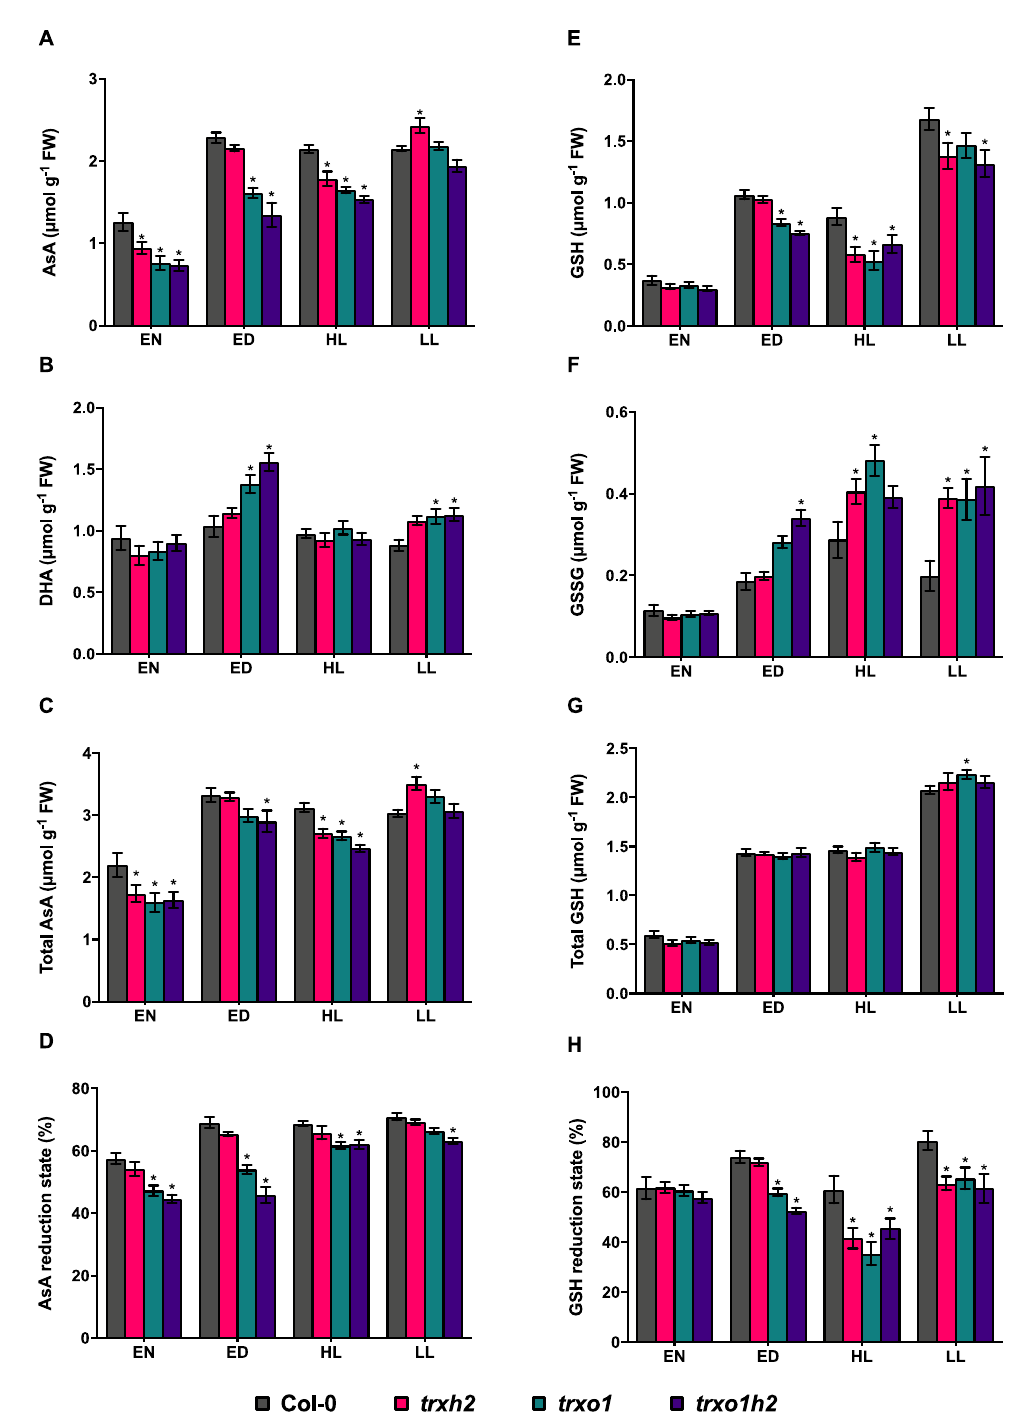
Figure 6. The redox couples of ascorbate (AsA) and glutathione (GSH) in the wild type (Col-0) and the mutant lines ( trxh2 , trxo1 and trxo1h2 ). Arabidopsis plants grown under medium light conditions were harvested at the end of the night (EN) and the end of the day (ED), respectively. Arabidopsis grown under fluctuating light condition were harvested at the high-light phases (HL) and low-light phases (LL), respectively. ( A ) The level of ascorbate. ( B ) The level of dehydroascorbate (DHA). ( C ) The level of total AsA. ( D ) The reduction state of AsA. ( E ) The level of reduced GSH. ( F ) The level of oxidized glutathione (GSSG). ( G ) The level of total GSH. ( H ) The reduction state of GSH. Mean values and standard errors derived from 6 biological replicates. The statistical analyses were performed using ANOVA and the Dunnett’s test (* p < 0.05, in comparison to the wild type).